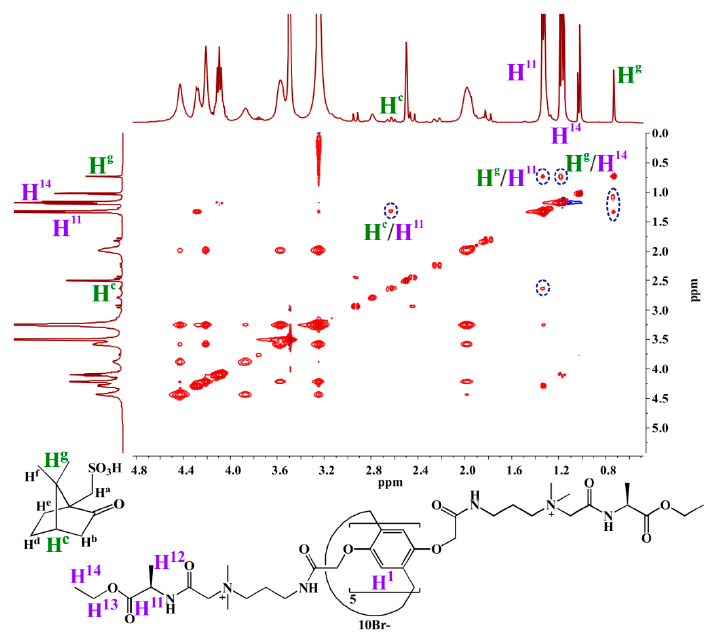
Figure 6. Fragment of 1 H- 1 H NOESY NMR spectrum of mixture of pillar[5]arene 13 (1 × 10 − 2 M) and (1S)-(+)-10-camphorsulfonic acid G2 (1 × 10 − 2 M) in DMSO-d 6 (293 K, 400 MHz). 2.4.3. Aggregation Study of pillar[5]arenes Containing Amino Acid Residues with Guests by DLS and